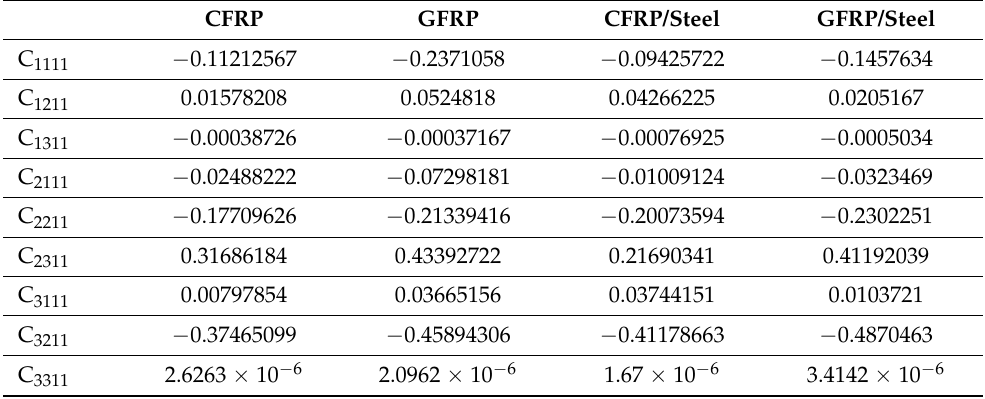
Table 3. Calibration coefficients C kl 11 *10 − 6 for the four different samples considered. Values are related to the first increment in the framework of the integral method. CFRP